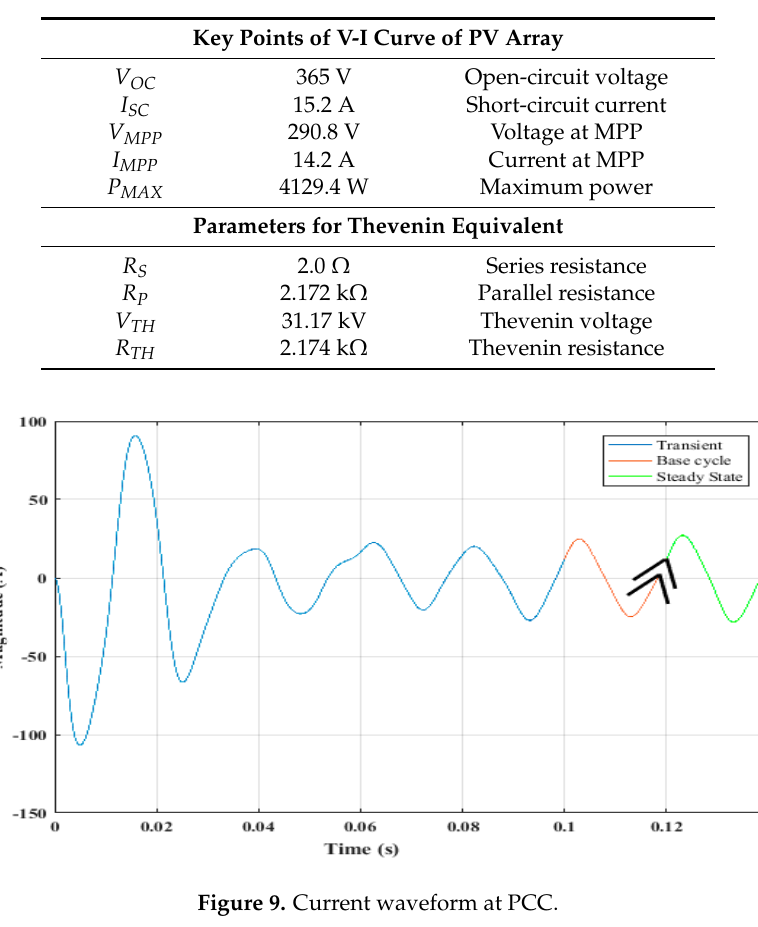
Table 2. Variables calculated for the PV generation system.